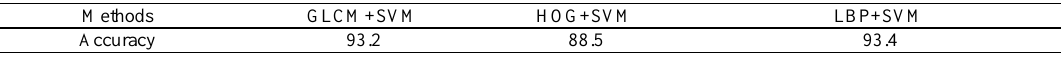
Table 6. Accuracy (%) score of traditional image classification methods